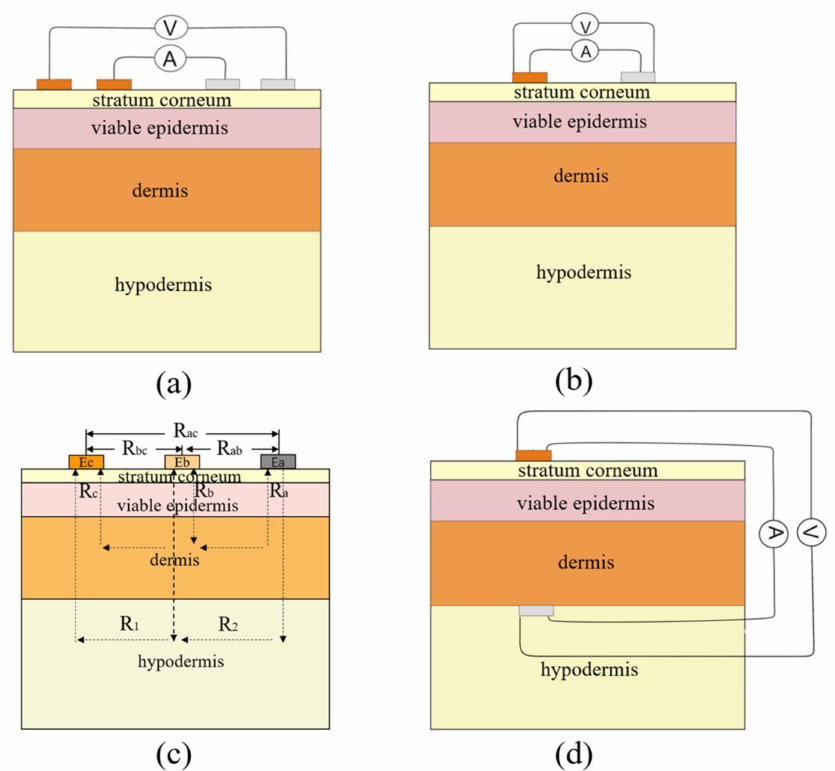
Figure 6. Four different measurement layouts of electrodes: ( a ) shows the layout of the four-electrode method, the inner two electrodes are response signal detection electrodes and the outmost two electrodes are stimulus signal electrodes; ( b ) represents the layout of the two-electrode method, the detection electrodes and the stimulus electrodes are multiplexing; ( c ) represents the layout of the three-electrode method, the skin is regarded as pure resistance [62]; ( d ) represents the layout of the tip-electrode method, the most direct and accurate way to detect skin impedance, but it is